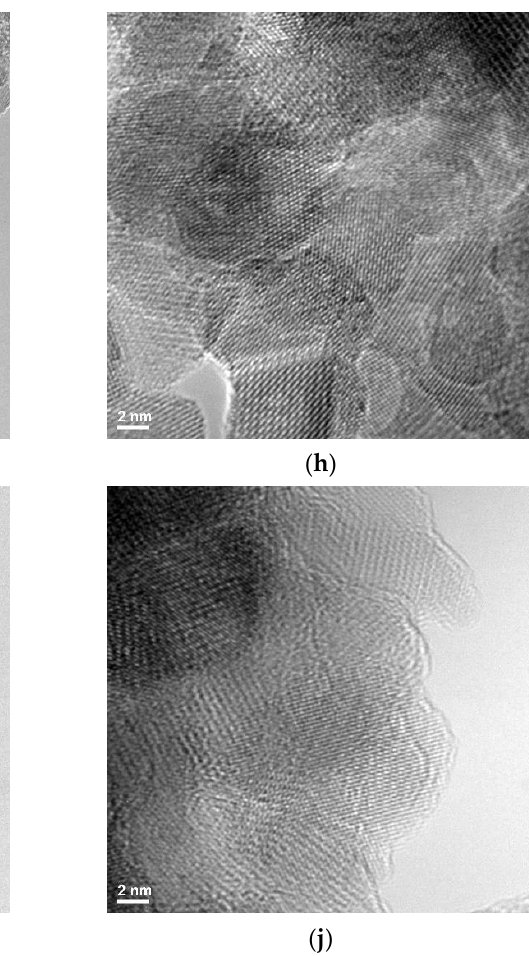
Figure 3. Transmission Electron Microscopy images for magnetic samples loaded with the fluorene derivatives: ( a , b ) Fe 3 O 4 @citrate, ( c , d ) Fe 3 O 4 @ citrate@1a, ( e , f ) Fe 3 O 4 @ citrate@1b, ( g , h ) Fe 3 O 4 @ citrate@1c, ( i , j ) Fe 3 O 4 @ citrate@1d.